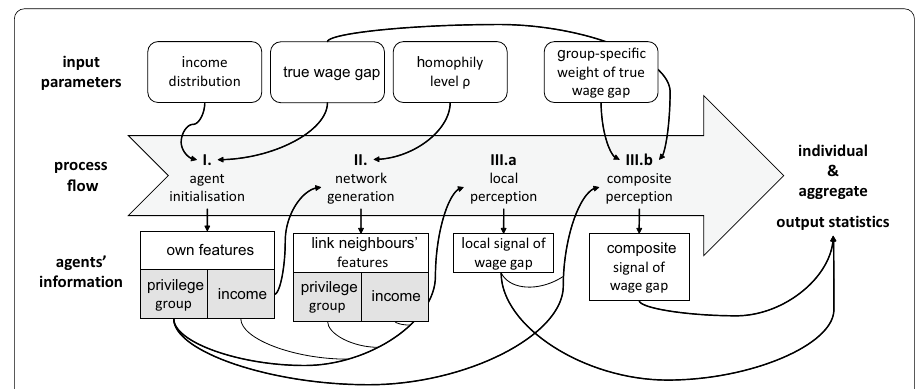
Fig. 1 Overview over the simulation